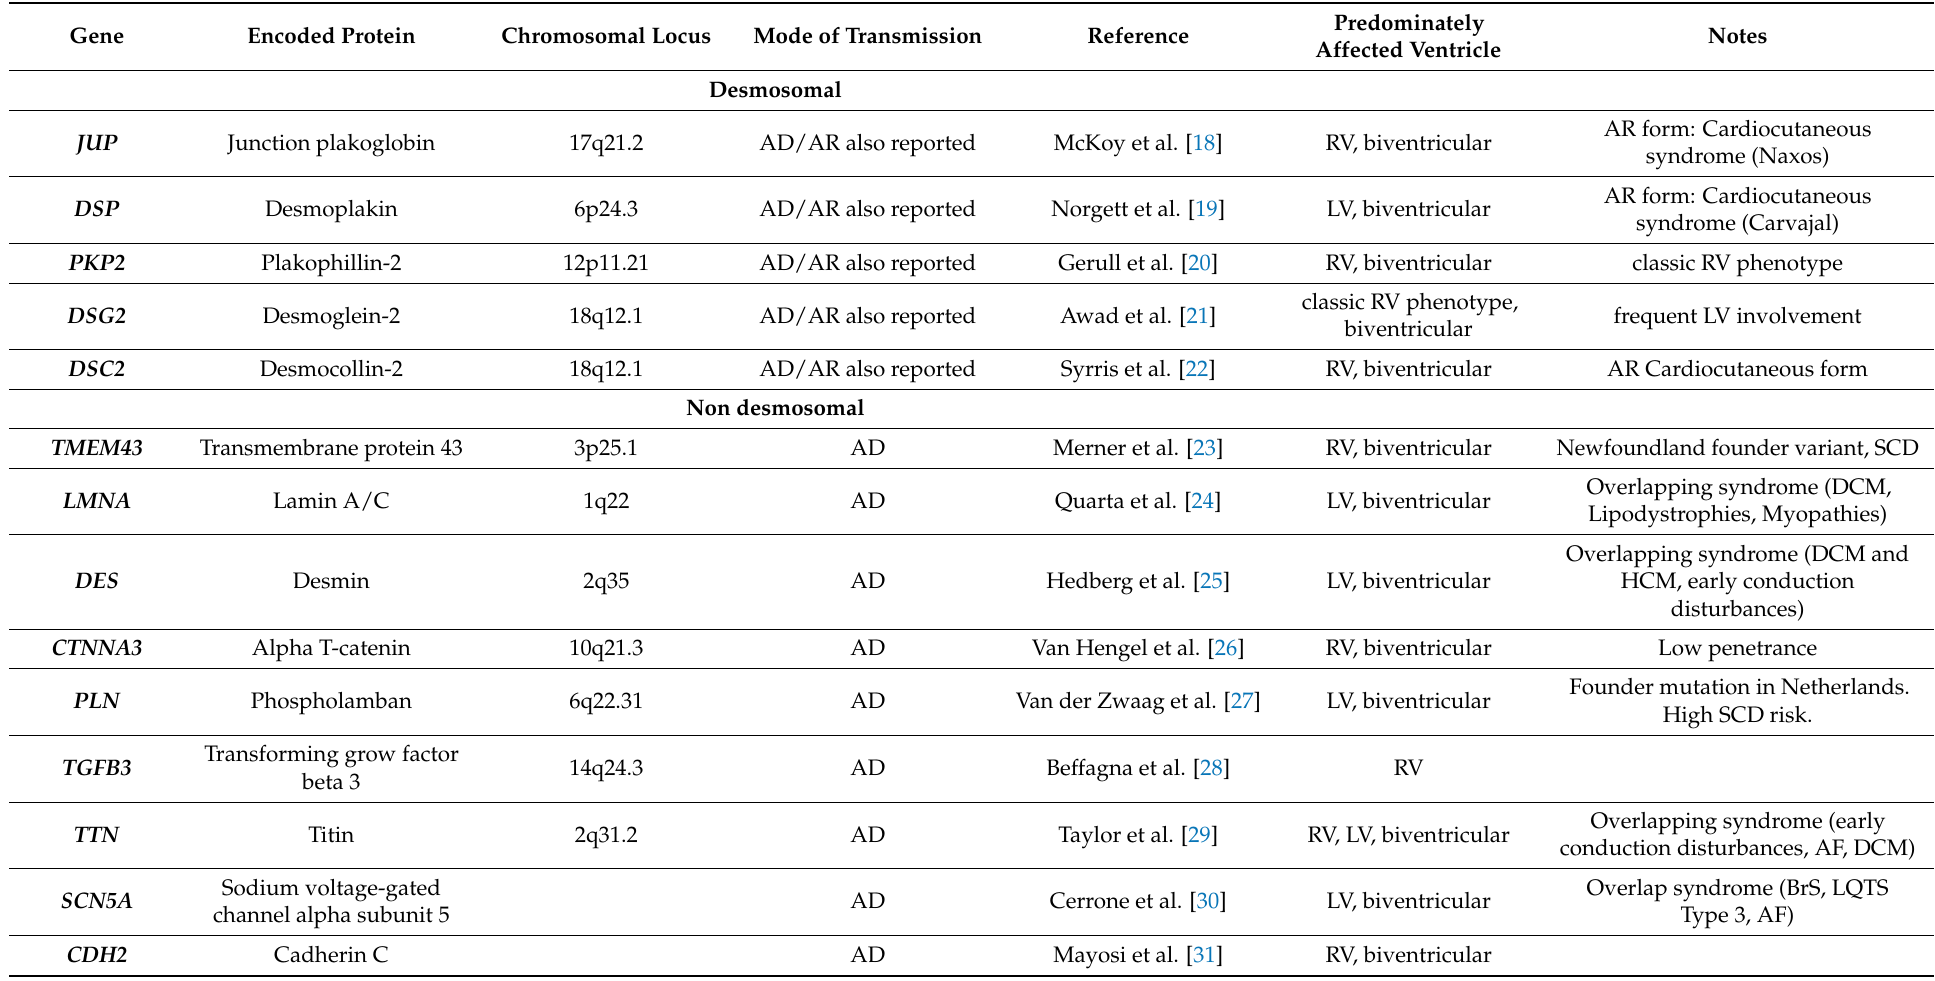
Table 1. Summary table for the genetic background of arrhythmogenic cardiomyopathy and its correlation with different phenotypes of the